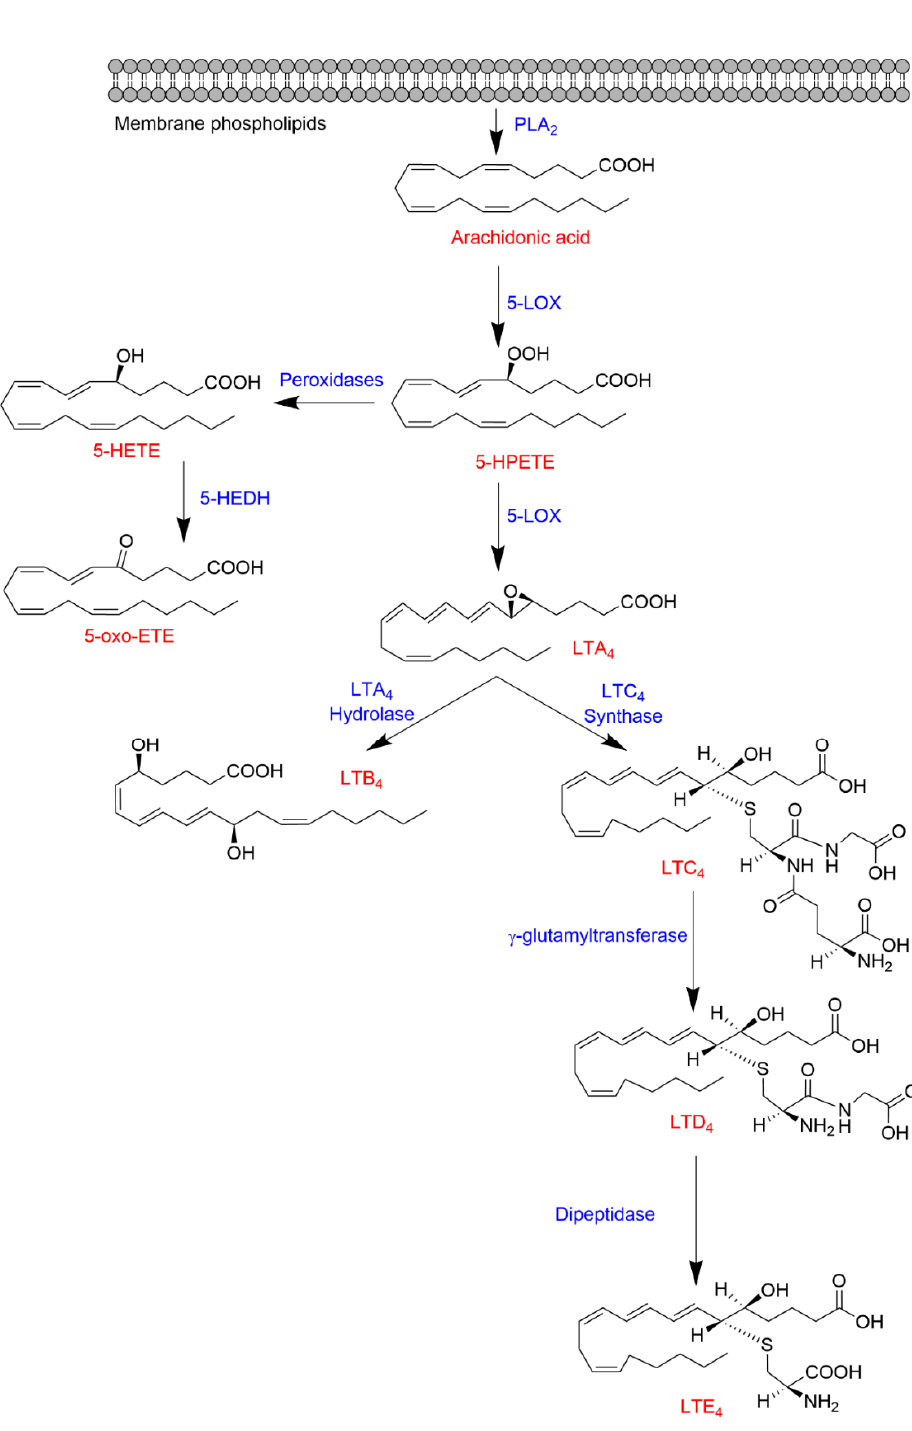
Figure 1. Biosynthesis of 5-HETE, 5-oxo-HETE, and LTs from arachidonic acid.